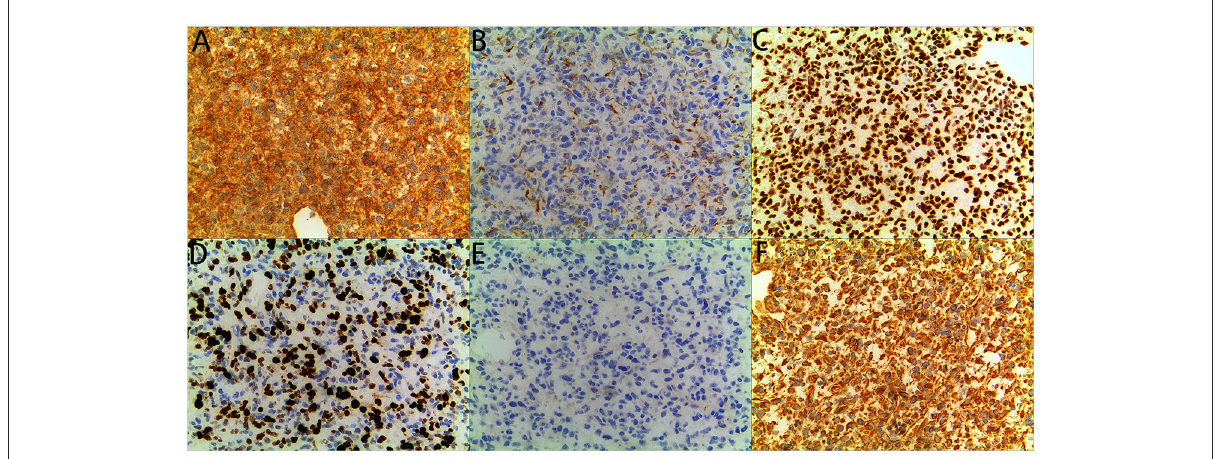
FIGURE4 immunohistochemical staining: The tumor showed diffuse immunoreactivity for (A) CD99, (C) INI1, (D) Ki-67, and (F) Vimentin, showed Partial immunoreactivity for (B) CK (AE1/AE3), showed no immunoreactivity for (E) MyoD1 (original magnification x200, for